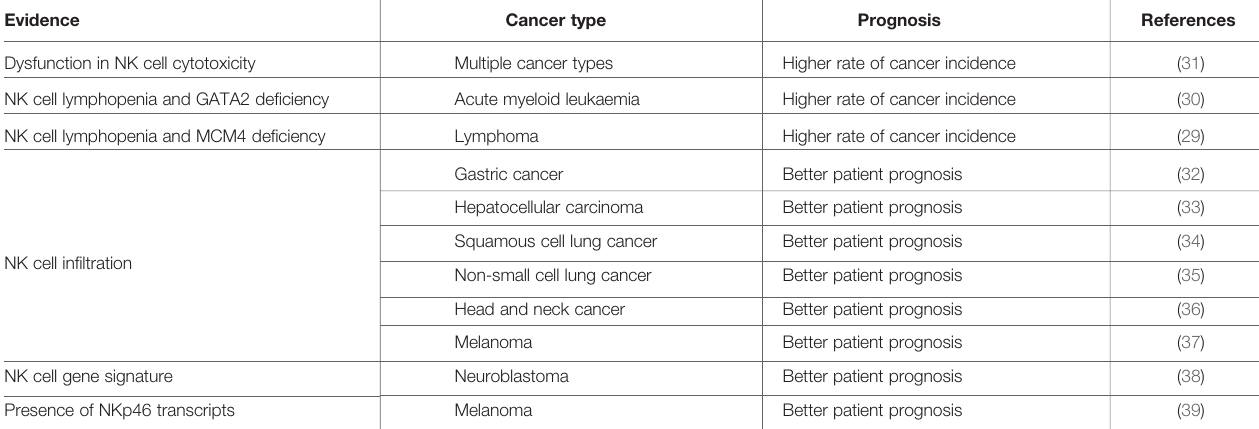
TABLE 1 | Clinical evidence for a role of NK cells in controlling